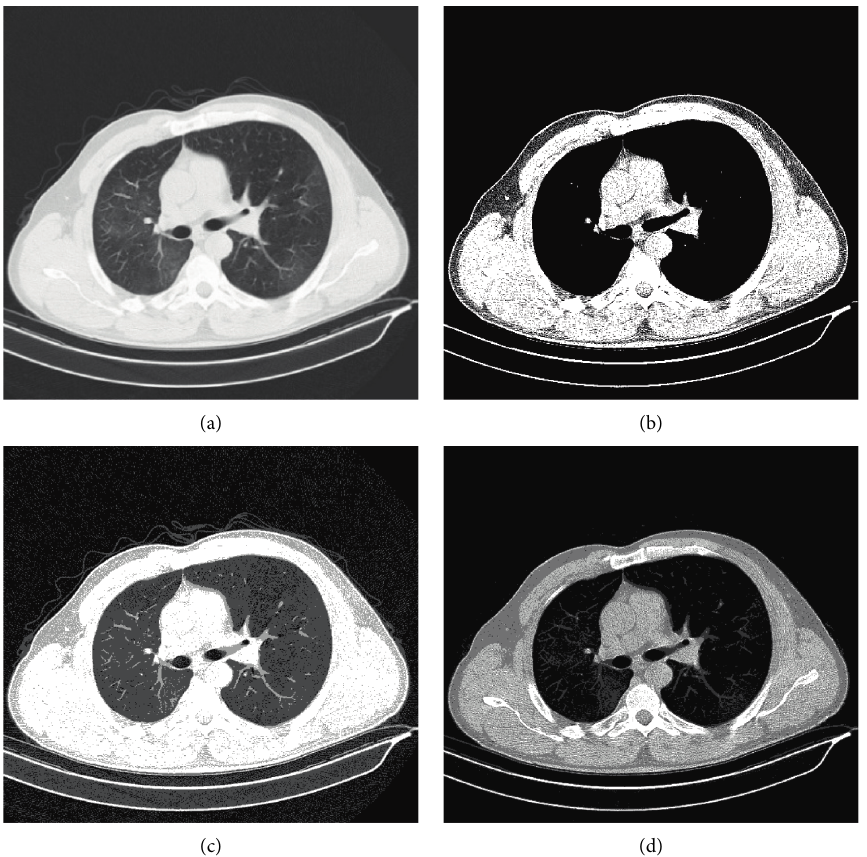
Figure 4: CT image-3 segmentation results of three threshold levels using the proposed approach. (a) Original CT image, (b) level-2 threshold segmentation, (c) level-3 threshold segmentation, and (d) level-4 threshold